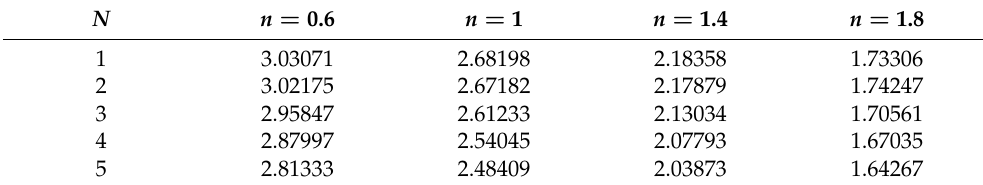
Table 8. The values of the average Nusselt number ( Nu avg ) at the heated boundary. N n = 0.6